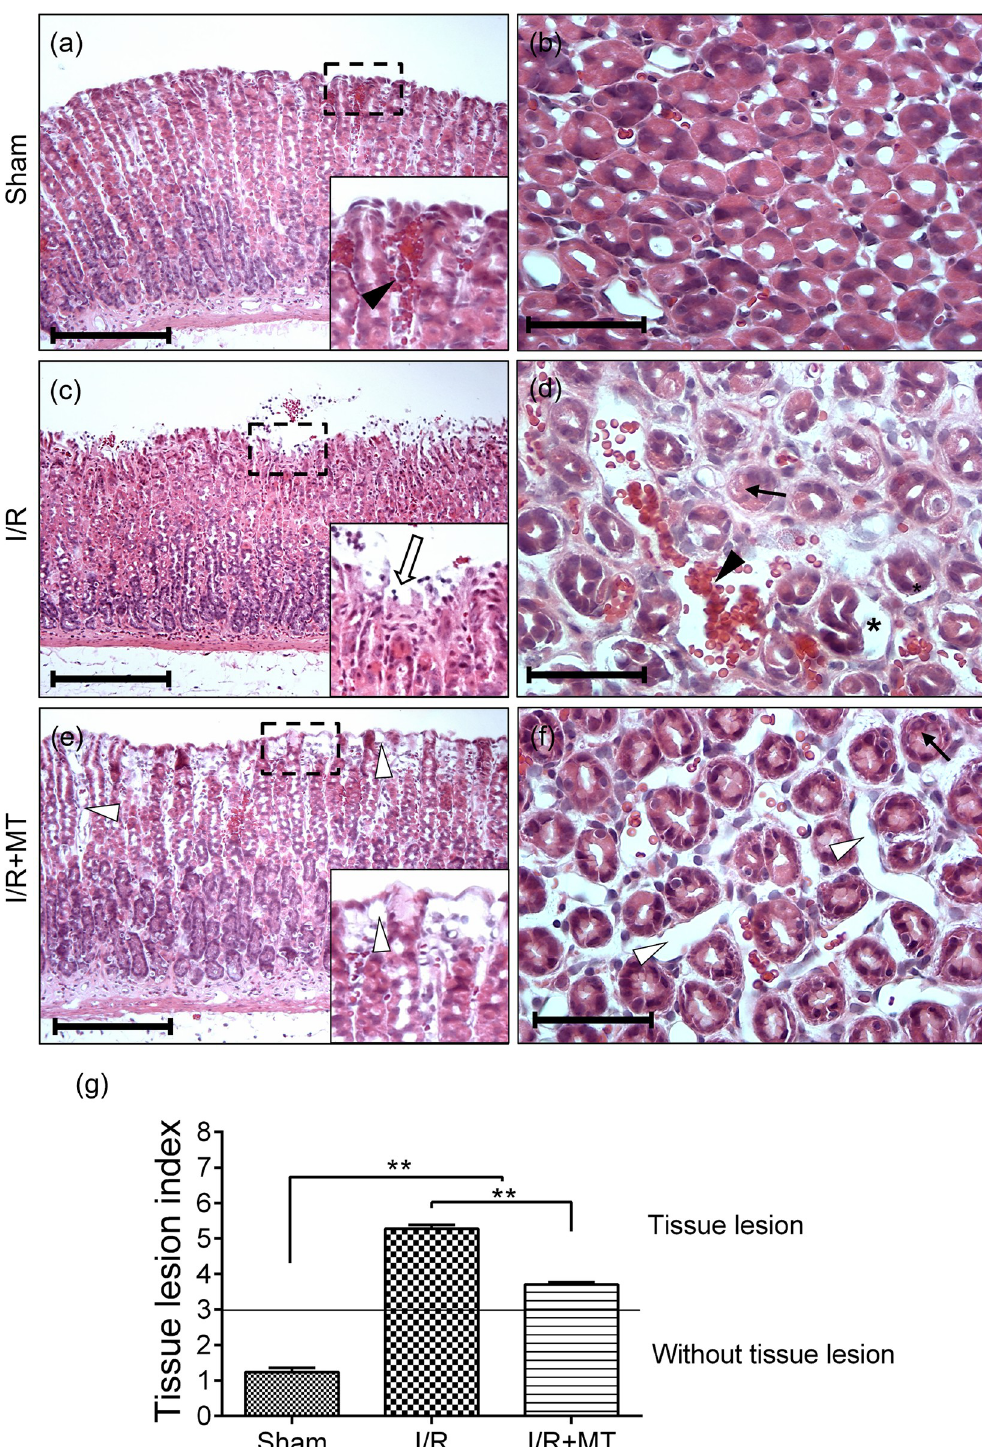
Fig 2. Effect of MT on histopathological alterations in the experimental groups. Representative photomicrographs of longitudinal (a), (c) and (e) and transverse (b), (d) and (f) sections of rat gastric mucosa. Sham (a) and (b), I/R (c) and (d) and I/R+MT (e) and (f) groups. Framed regions were enlarged to show (a) vascular congestion, (b) epithelial erosion and (c) granulation tissue. Identifiers: (black arrowhead) vascular congestion, (white arrow) epithelial erosion, (black arrow) damaged cell, ( ⁎ ) epithelial detachment, (white arrowhead) vascular dilation. H-E. Scale bar: 200 μ m (a), (c) and (e). Scale